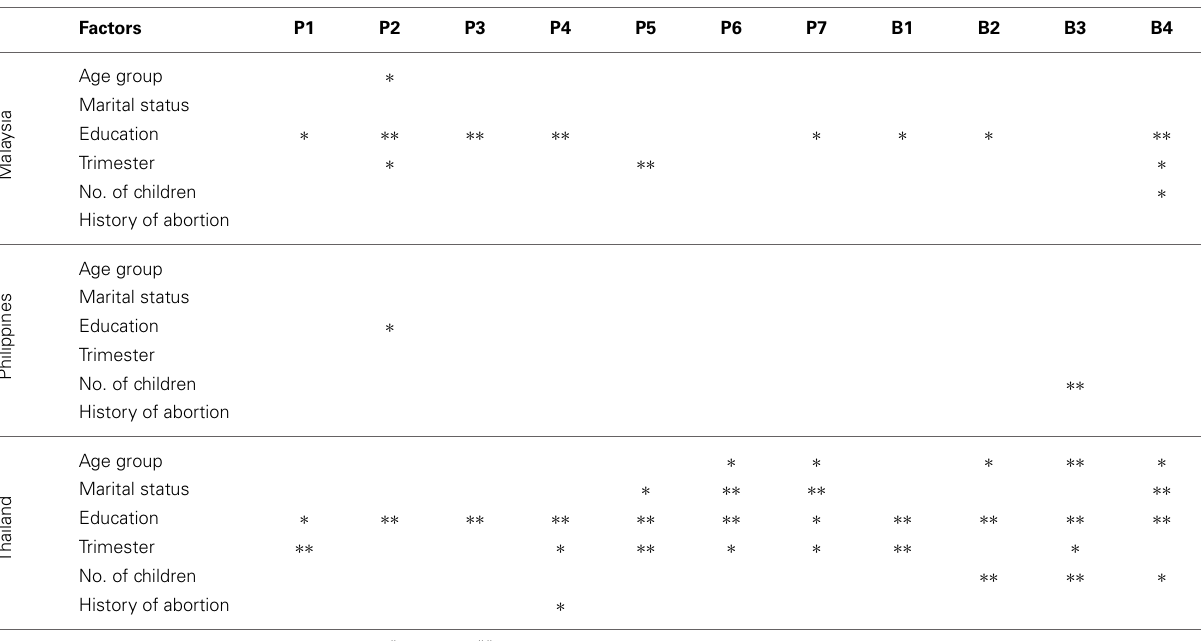
Table 3 | Association between demographic profiles of pregnant women from each country with their preventive knowledge and preventive behavior on